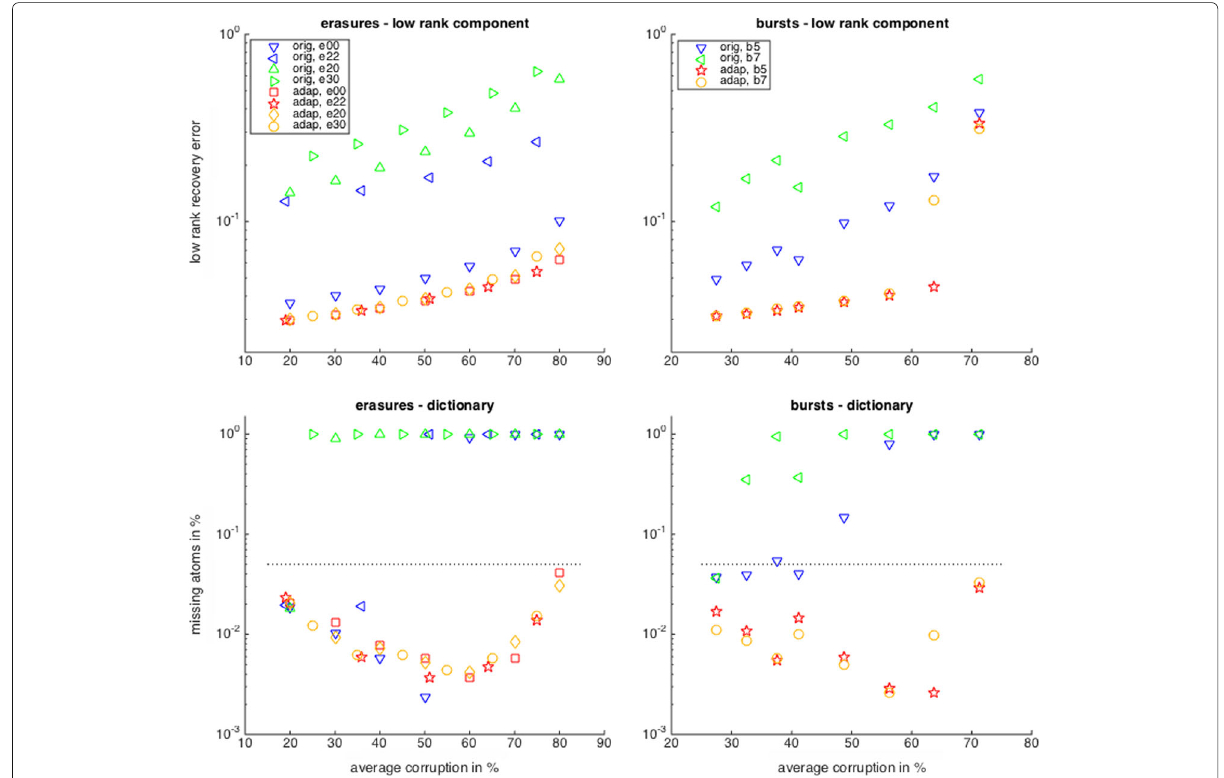
Fig. 3 Detailed recovery performance of the corruption adapted versus the unadapted learning algorithms for the random low-rank component (top) and dictionary (bottom) for random erasures (left) and burst errors